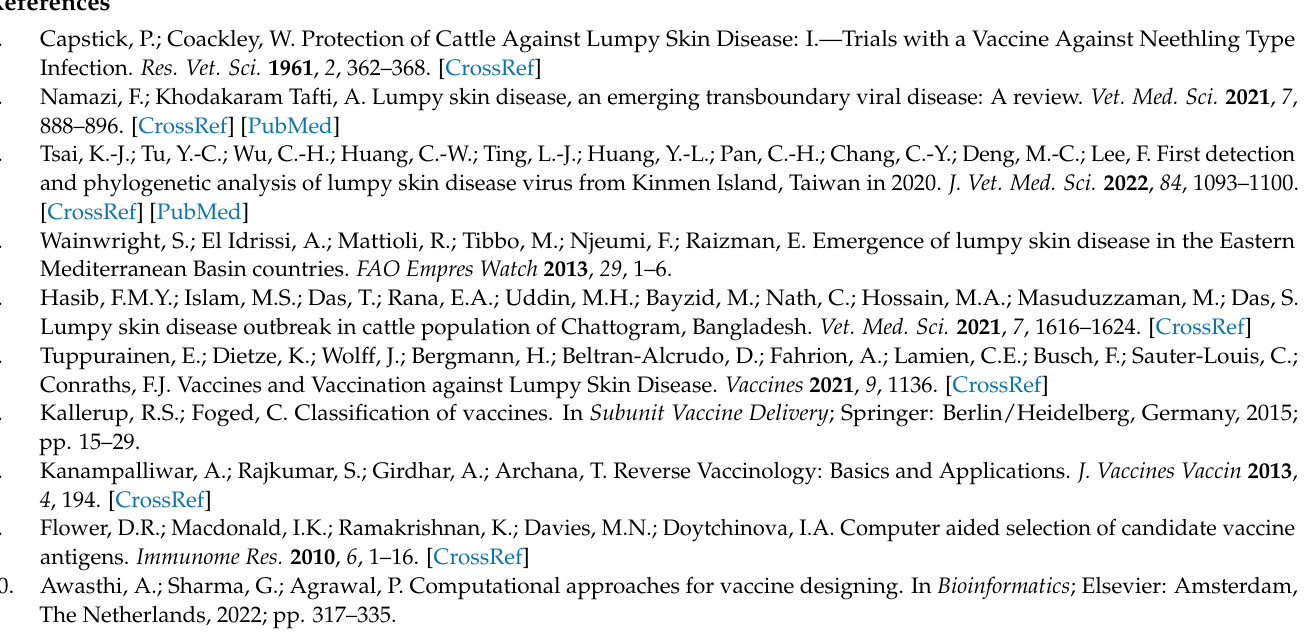
T-cell epitope prediction; Table S2: Designed vaccine constructs with allergenicity, antigenicity, and solubility analysis; Table S3: Refined models of vaccine construct LSDV-V2 predicted by Galaxy Refine server; Table S4: DNA and RNA sequences of the peptide vaccine constructs; Table S5: Different residues of vaccine construct and TLR4 involved in hydrogen bonding; Figure S1a: Secondary structure prediction for LSDV-V1 by PSIPRED server, Figure S1b: Secondary structure prediction for LSDV-V2 by PSIPRED server; Figure S1c: Secondary structure prediction for LSDV-V3 by PSIPRED server; Figure S2a: Secondary structure prediction for the prioritized LSDV-V1 mRNA construct. Figure S2b: Secondary structure prediction for the prioritized LSDV-V3 mRNA construct. Figure S3: Three-dimensional structural validation of V1 and V3. Figure S4: In silico immune simulation of LSDV-V2 chimeric peptide predicted by C-ImmSim Server. Section S1: mRNA vaccine construction layout; Supplementary File S1: The entire proteome of LSDV Neethling 2490 strain; Supplementary File S2: Non-paralogous host non-homologous proteins of